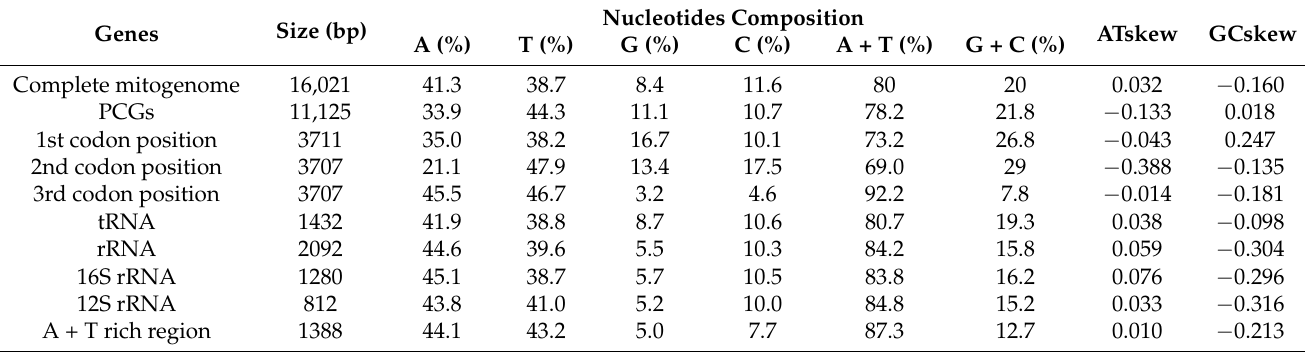
Table 3. Nucleotide composition of the Luperomorpha xanthodera mitogenomes.